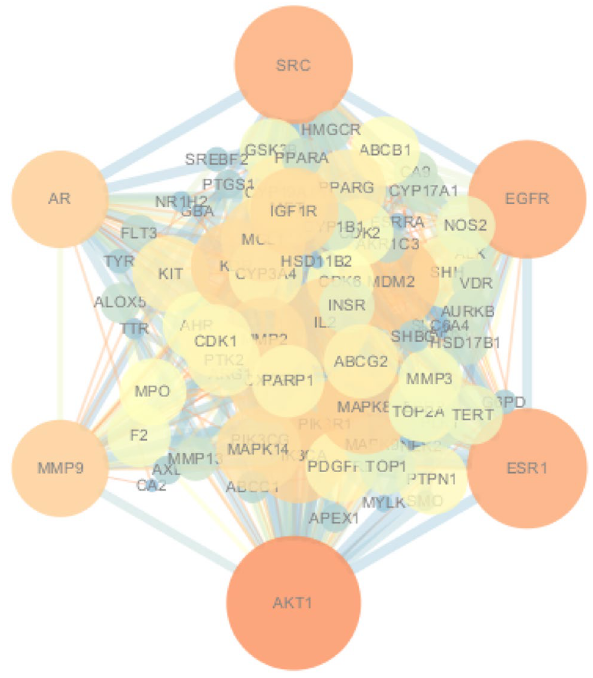
Fig. 2 PPI network for the 80 common targets between S. nigrum bioactive compound targets and breast cancer